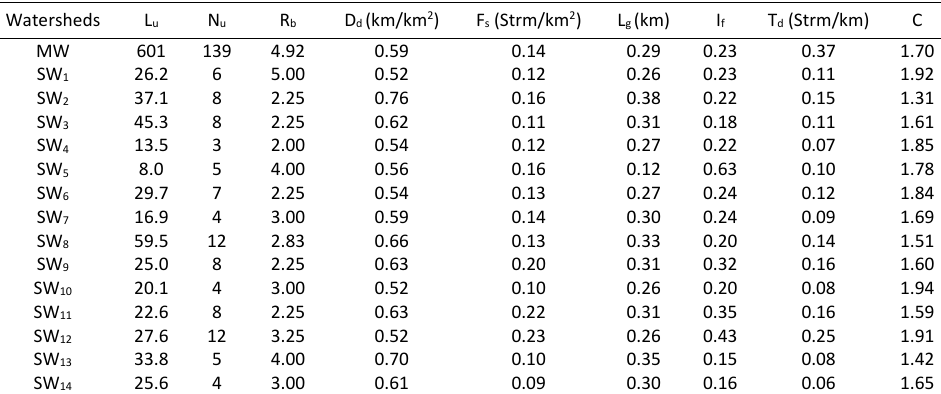
Table 2: Geomorphometric values for channel parameters Table 2. Geomorphometric values for channel parameters